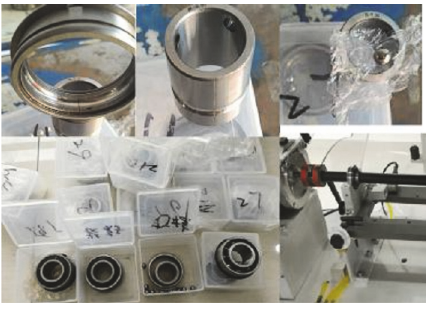
Figure 23: SER205